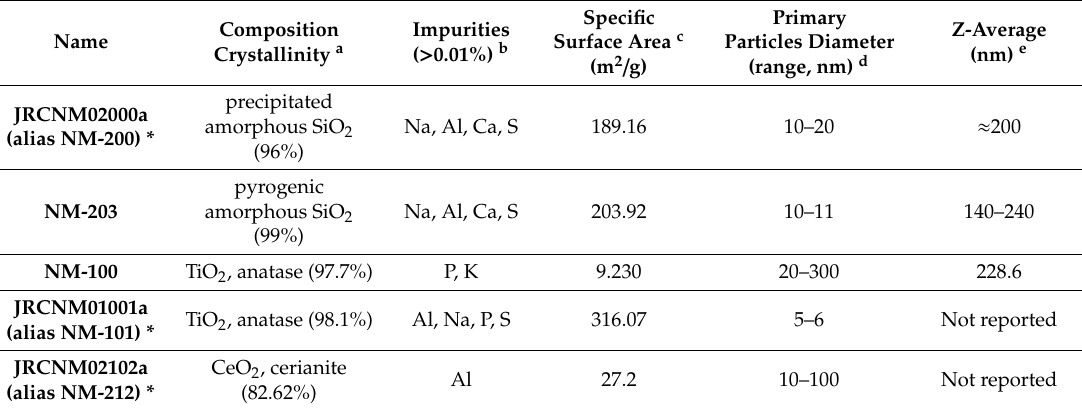
Table 1. Main physico-chemical properties of the samples